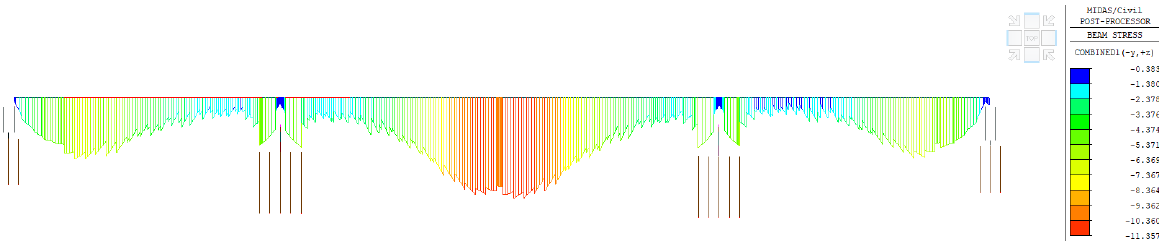
Figure 9. Sample of stress distribution in the bottom of deck (MPa) at time T=100y - frequent combination.